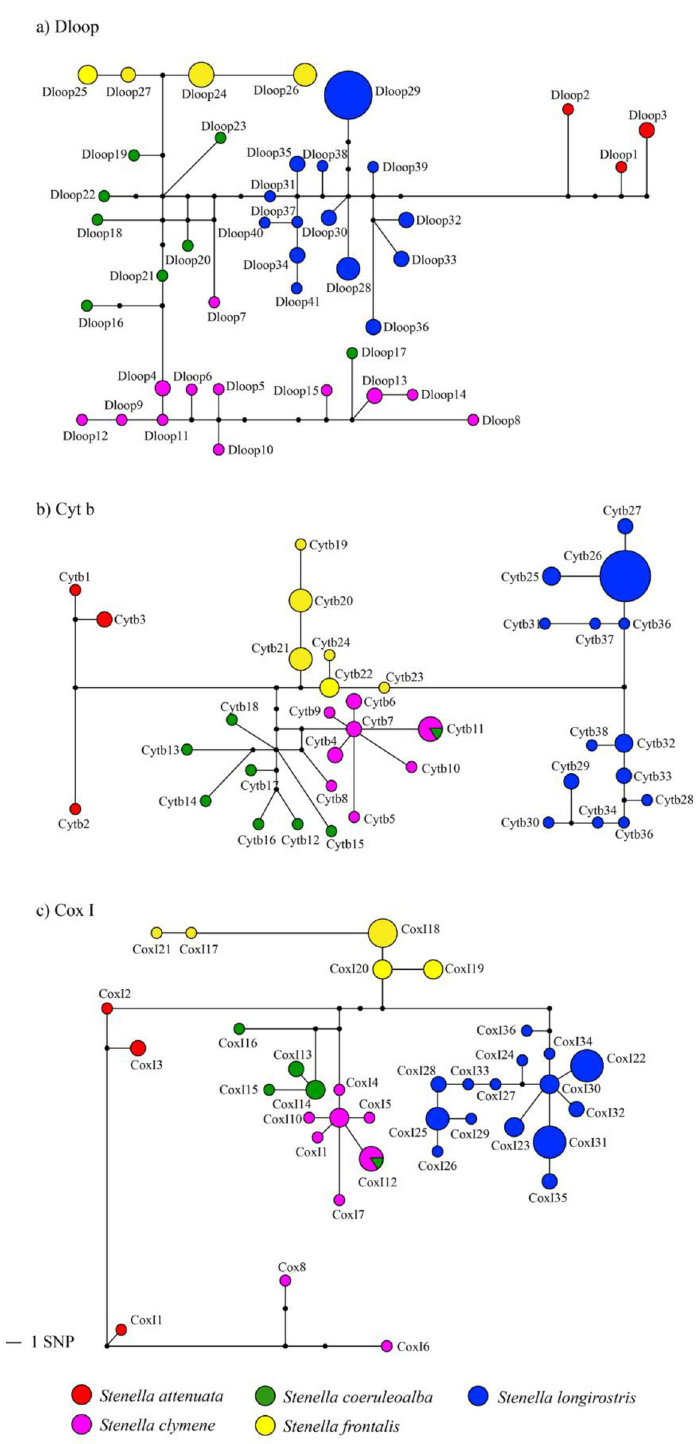
Fig 2. Median-Joining network of Stenella species from Brazilian waters for mtDNA control region (Dloop), cytochrome b (Cytb), and cytochrome oxidase subunit I (CoxI). Each circle corresponds to a haplotype, and its size is proportional to its frequency. Black circles indicate missing or intermediate haplotypes. Lengths of lines connecting haplotypes are proportional to the number of substitutions between haplotypes.